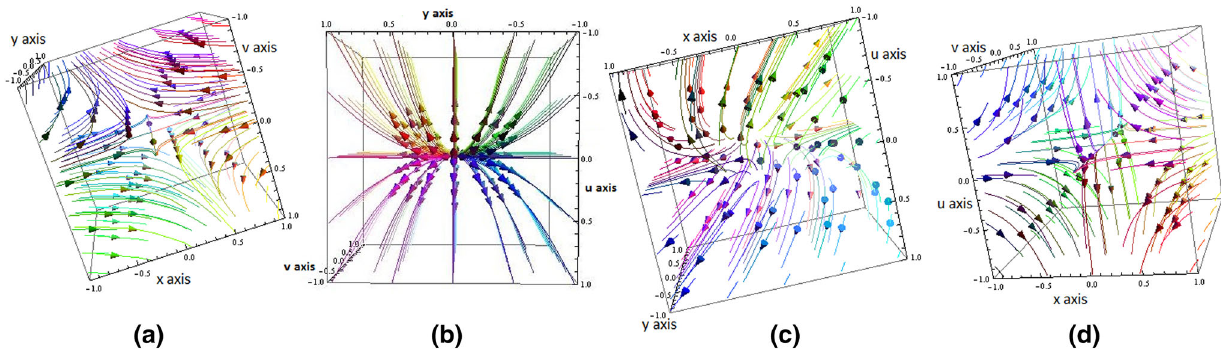
coordinate system (saddle node), d represents phase plot in x v u - coordinate system (saddle node). We refer the interested readers to Appendix A for corresponding Mathematica code